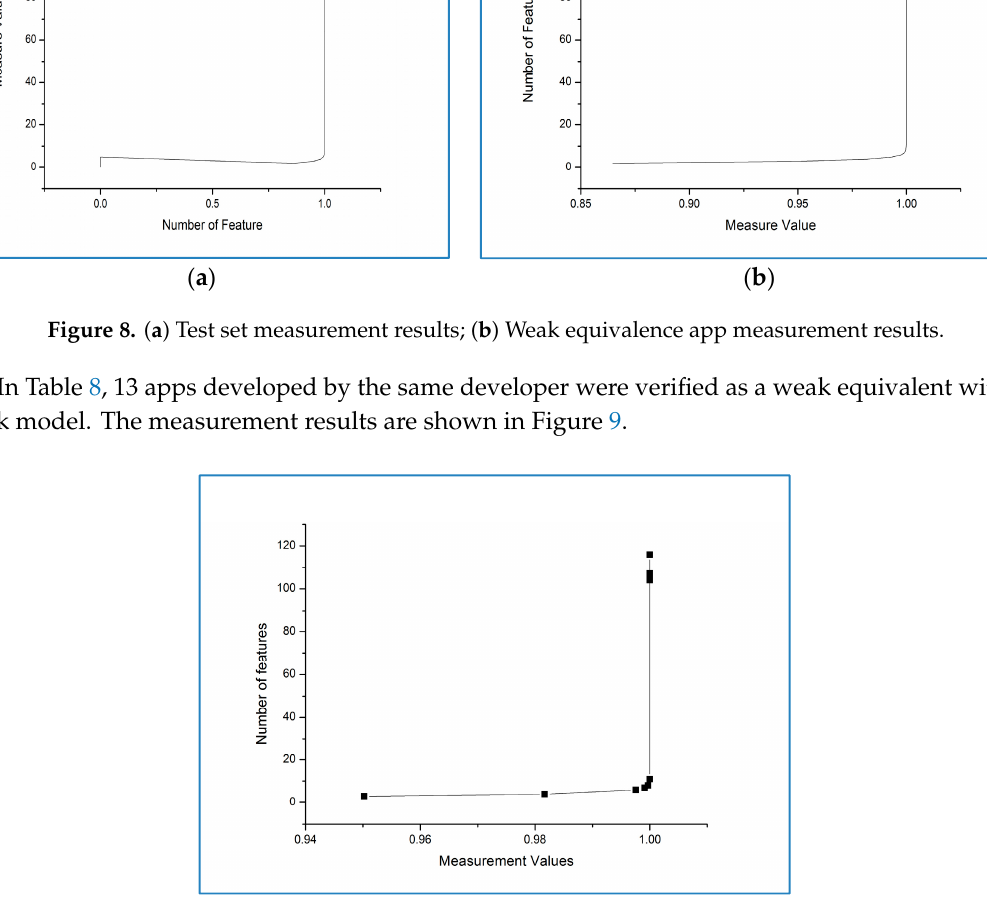
Figure 9. Measurement results for app developed by the same developer.